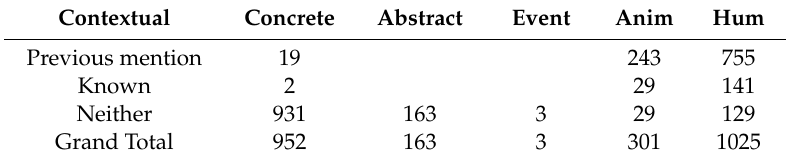
Table 6. Cross-tabulation of semantic type of nouns against contextual status of the DP.